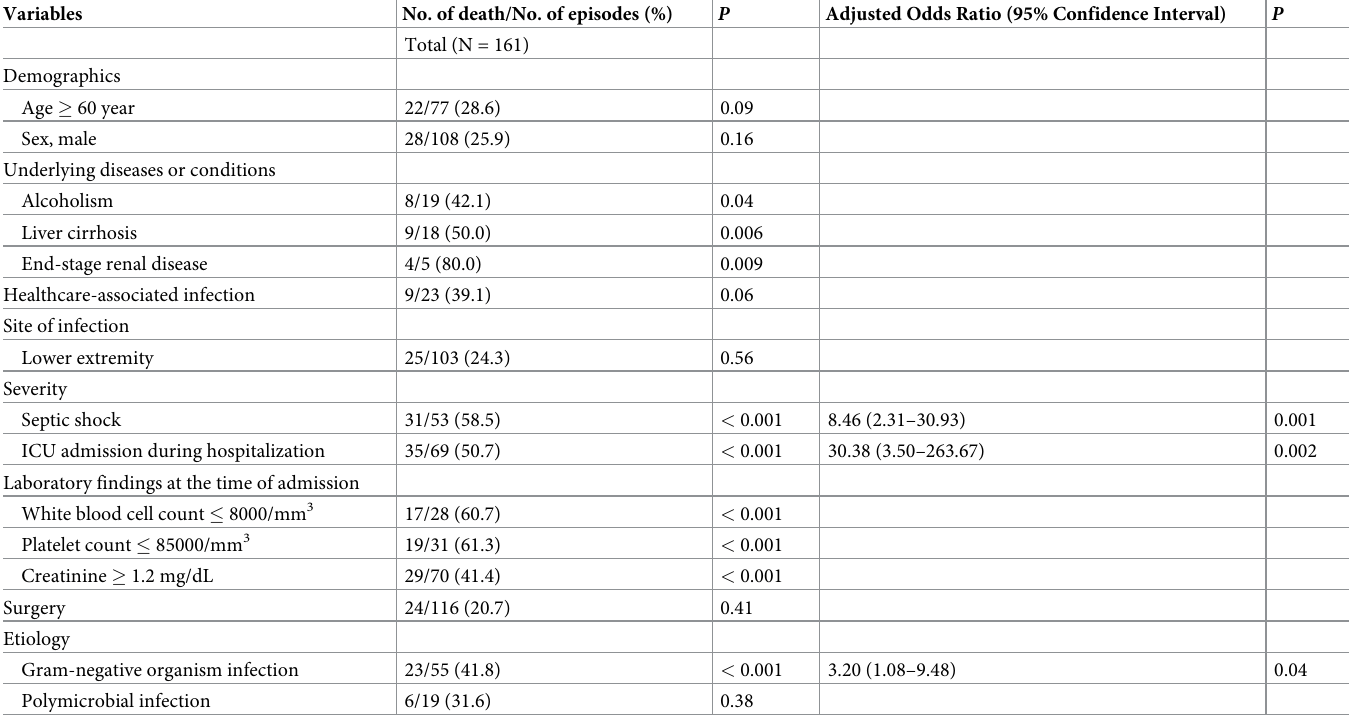
Table 5. Risk factors associated with an in-hospital mortality of patients with community-onset necrotizing